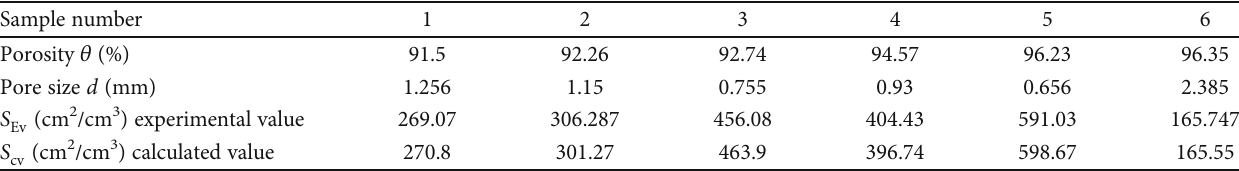
Table 1: Experimental data and theoretical calculation data of copper